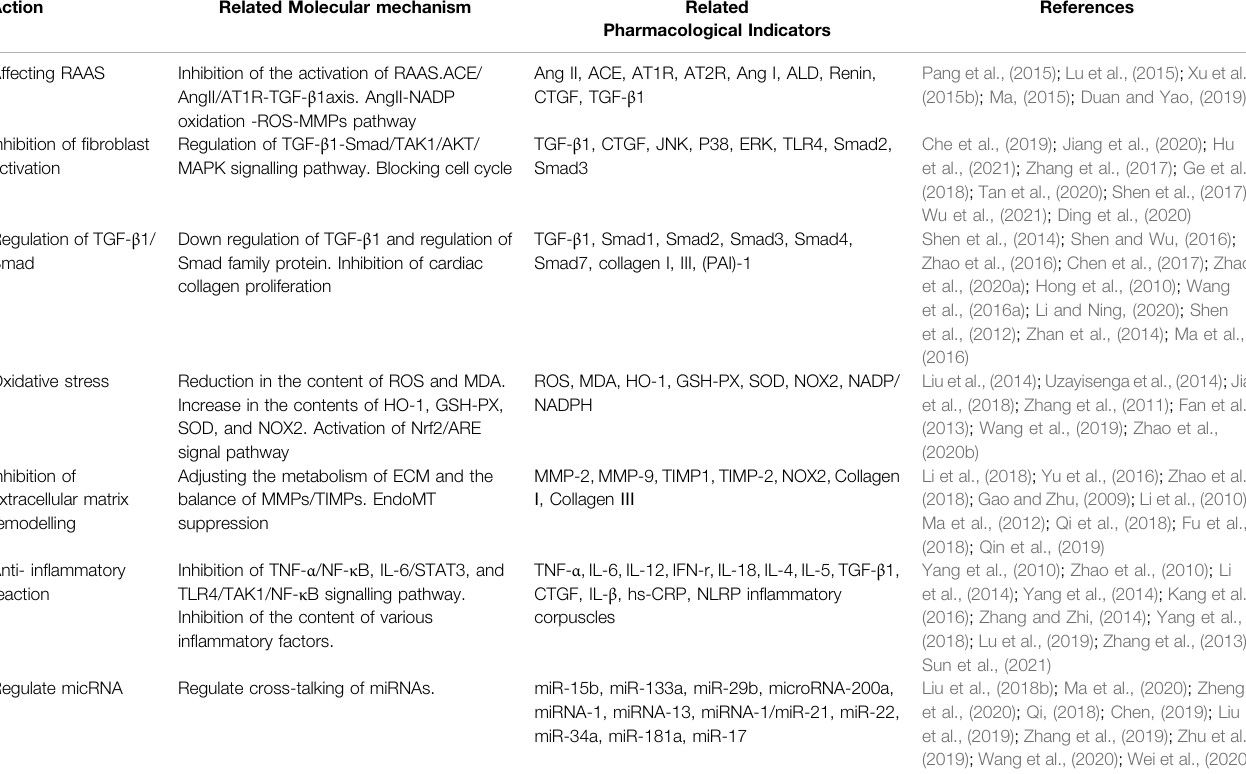
TABLE 1 | Key areas and mechanisms of traditional Chinese medicine in treating myocardial fi